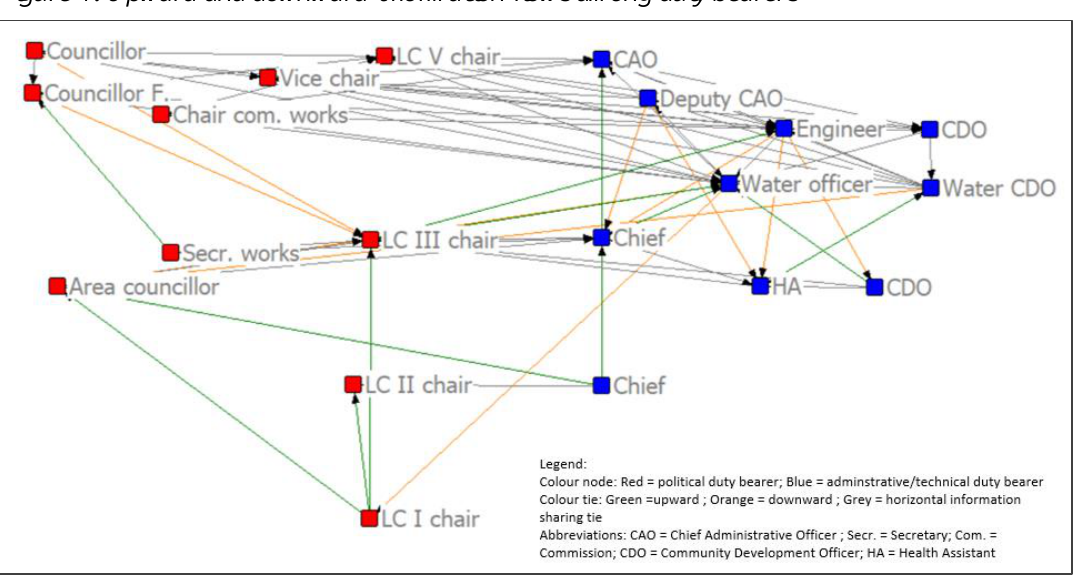
Figure 4 maps the upward (green), downward (orange) and horizontal (grey) information-sharing between the different governance levels. At district level, the overwhelming majority of information- sharing is horizontal, either among political duty bearers, among technical/administrative staff or between technical/administrative staff and political duty bearers. Some downward information-sharing to sub-county level also takes place, mostly originating from the district technical office. With the one exception of information flow from the DWO to the village leader, there is limited downward information flow from the district beyond sub-county level. Figure 4: Upward and downward information flows among duty